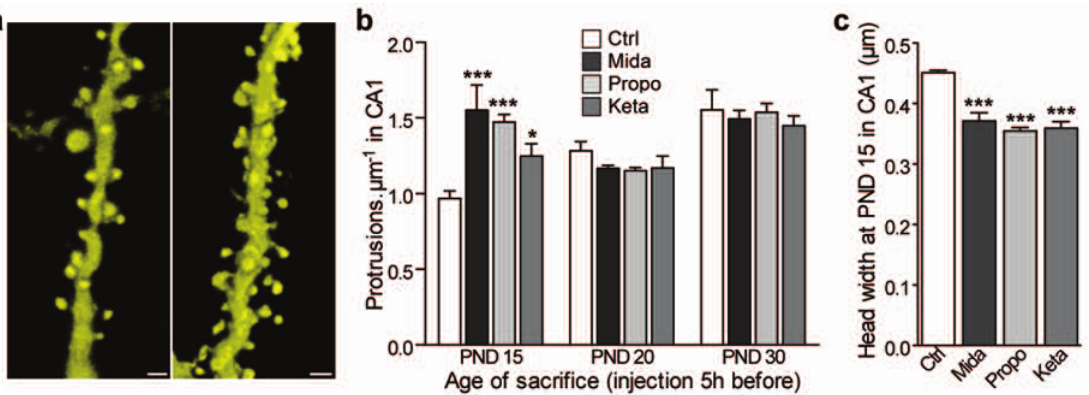
Figure 4. Effects of midazolam, propofol and ketamine on dendritic protrusions in the hippocampus invivo . ( a ) 3D volume rendering of confocal microscopy images of apical dendrites of CA1 hippocampal neurons of PND 15 mice in control (left) and midazolam-anesthetized (right) conditions. Scale bars: 1 m m. ( b ) Protrusion density of pyramidal neurons of mice sacrificed at PND 15; 20 and 30 just after a 5 h-anesthesia with midazolam (Mida) propofol (Propo) or ketamine (Keta) compared to control conditions (ctrl). ( c ) protrusion head width in PND 15 mice CA1 neurons after 5 h-midazolam (Mida), propofol (Propo) or Ketamine (Keta) anesthesia compared to control group. (b, c): n =4 animals per group, 1291 spines; ***: P , 0.001, *: P , 0.05, two-way ANOVA with Bonferroni post tests.